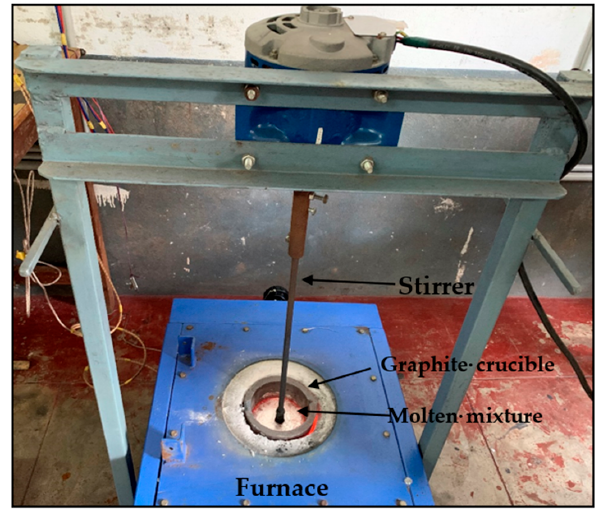
Figure 2. Stir casting experimental setup used in the current study.